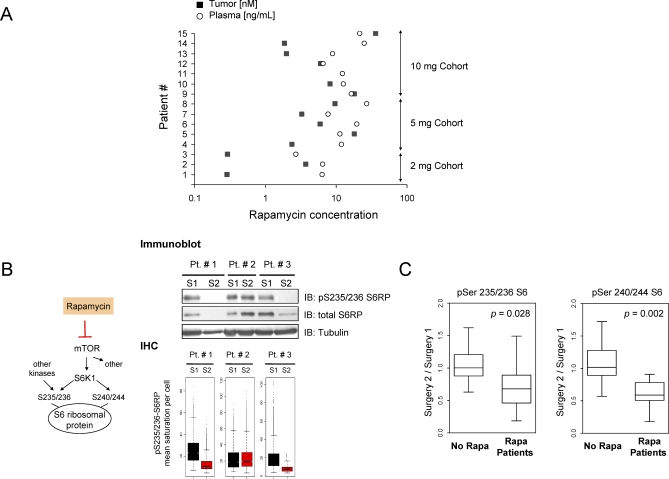
Rapamycin Crosses the Blood–Brain Barrier and Blocks mTOR in Tumor Tissue(A) Rapamycin concentrations in tumor tissue (filled squares) and peripheral blood (empty circles) grouped by rapamycin dose cohorts (2 mg, 5 mg, or 10 mg per os daily). Intratumoral rapamycin concentration for patient 11 could not be determined due to insufficient frozen tumor material. The last preoperative dose of rapamycin was given on the day of craniotomy and peripheral blood was collected within 24 h of surgery.(B) Quantification of mTOR activity in tumor tissue by immunohistochemistry. The cartoon to the left depicts the S6 kinase 1 branch of the mTOR signaling pathway resulting in phosphorylation of S6 ribosomal protein at serine 235/236 and serine 240/244. The panel to the right shows a comparison between immunoblotting (top) and IHC (bottom) for the determination of S6 phosphorylation in tumor tissue from rapamycin patients 1, 2, and 3. The fold change in serine 235/236 phosphorylation between S2 and S1 for patients 1, 2, and 3 were 0.45, 1.01, and 0.45, respectively (see Figure S2A).(C) Changes in S6 phosphorylation between S2 and S1 (y-axis: ratio of S6 phosphorylation in S2 sample to S6 phosphorylation in S1 sample) for all patients for whom matched S1 and S2 samples were available (14/15 rapamycin patients and 9/9 patients who did not receive rapamycin). S6 phosphorylation was determined by IHC using phosphosite-specific antibodies against serine 235/236 (left) and serine 240/244 (right). Please see Figures S1 and S2 for details regarding IHC scoring method and results for individual tumors. p-values for the difference in mean S2/S1 ratios for each group were determined using the Kruskal Wallace test.